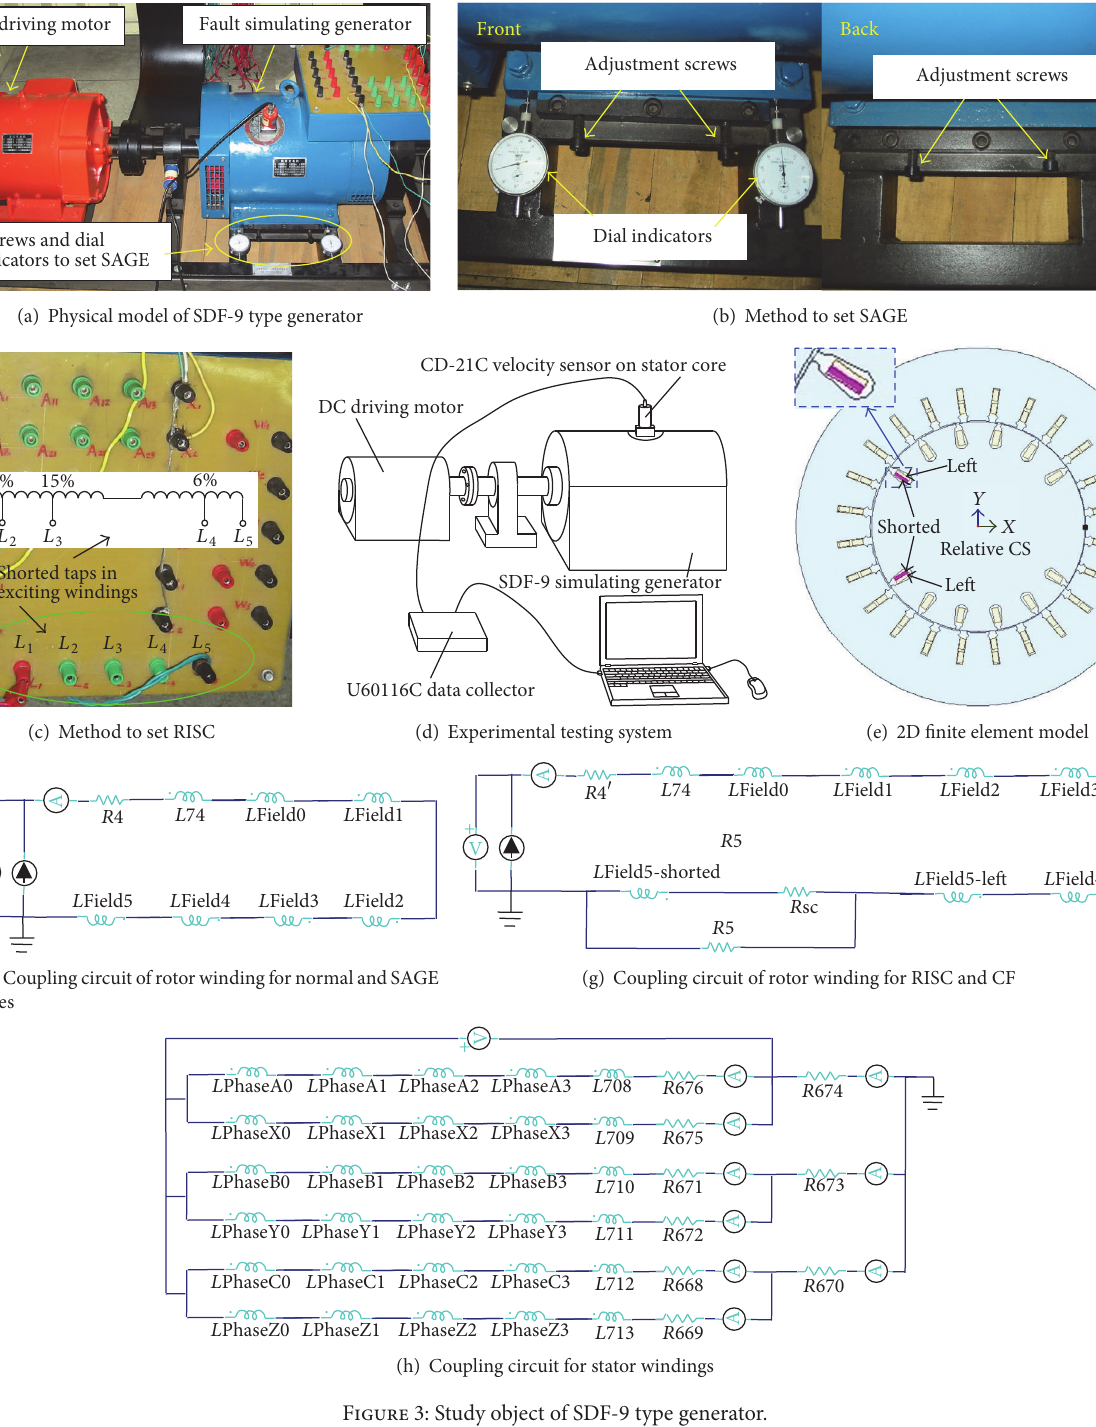
Figure 3: Study object of SDF-9 type